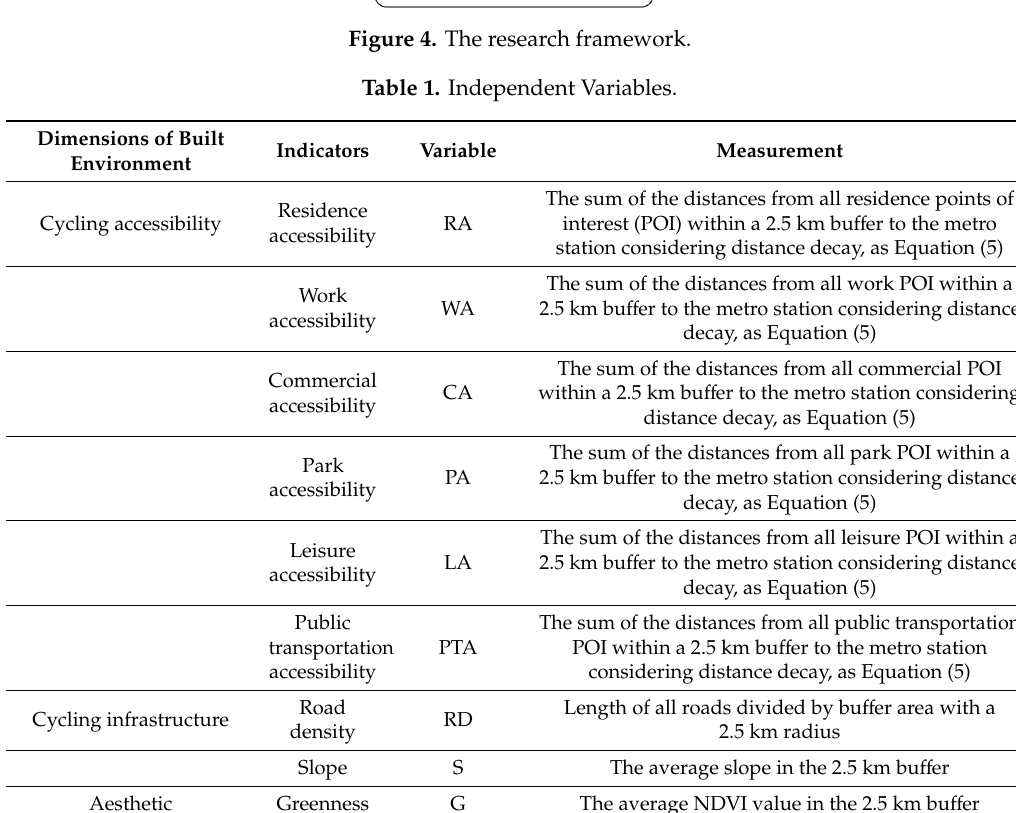
Table 1. Independent Variables.